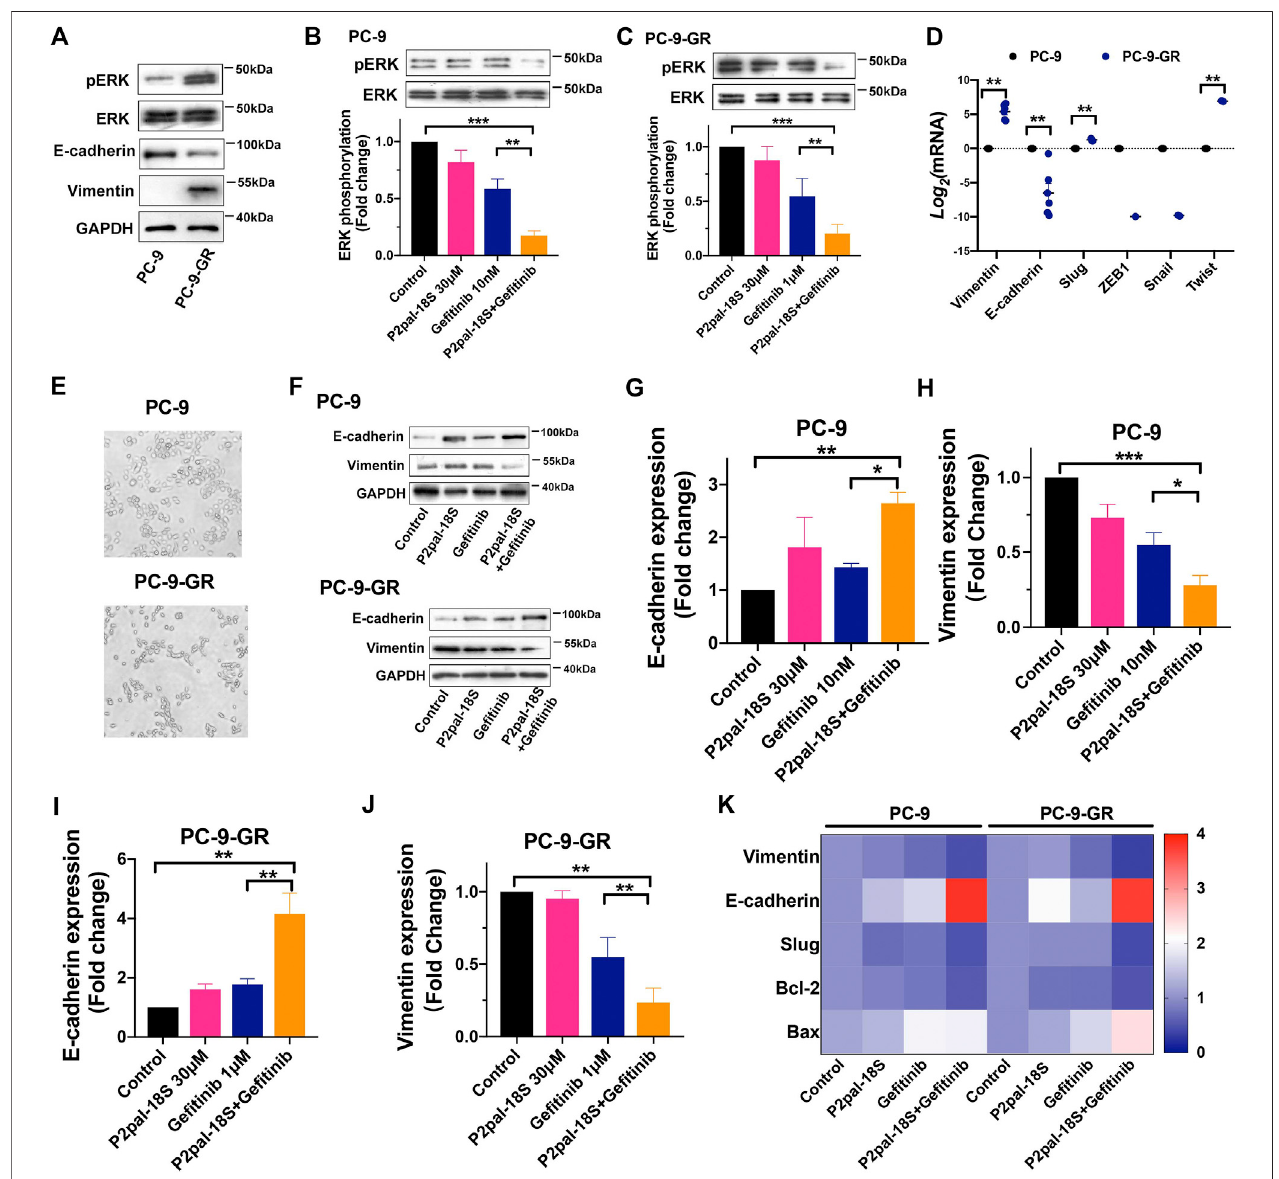
FIGURE 3 | Targeting PAR2 enhanced ge fi tinib inhibition in ERK phosphorylation and EMT. (A) . Protein expressions of total or phosph-ERK, E-cadherin and vimentin were increased in PC-9-GR cells; (B – C) . P2pal-18S promoted ge fi tinib to inhibit phosphorylation of ERK in PC-9 (B) and PC-9-GR cells (C) ; (D) . EMT-related gene expressions were detected and compared in ge fi tinib-sensitive and -resistant cells; (E) . The morphology of PC-9 and PC-9-GR cells was observed; (F – J) . P2pal- 18S facilitated ge fi tinib to increase expressions of E-cadherin and decrease expressions of vimentin; (K) . The heat map of gene expressions of vimentin, E-cadherin, Slug, Bcl-2 and Bax by different treatments compared with control group (value (cid:1) 1) in PC-9 and PC-9-GR cells, respectively. * p < 0.05, ** p < 0.01, *** p < 0.001.